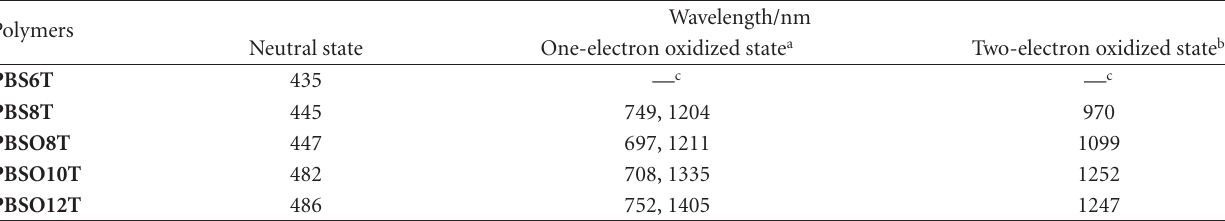
Figure 5: Di ff erence absorption spectra of PBS8T film at 0.6 and 0.9 V referred to spectrum of neutral PBS8T film. The inset shows absorption spectrum of neutral PBS8T film. Table 1: Absorption maxima of neutral and oxidized